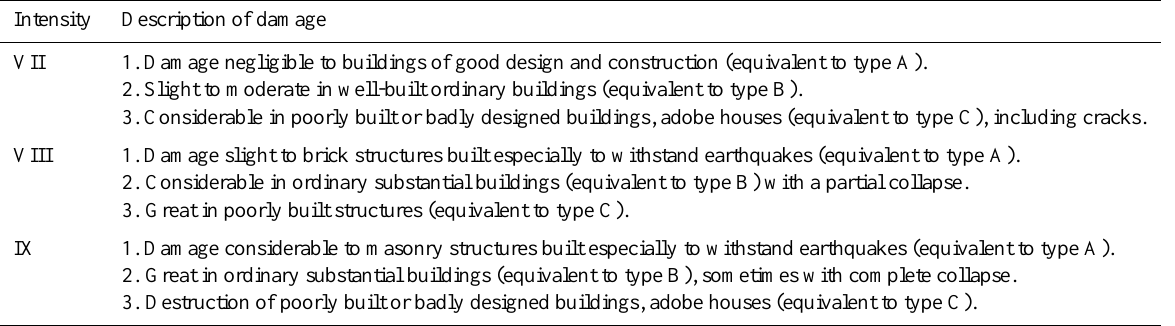
Table 3. Expected damage to buildings according to the Modify Mercalli intensity scale (extracts from Wood and Neumann, 1931, with some additions from Richter, 1958; Tiedemann, 1992).